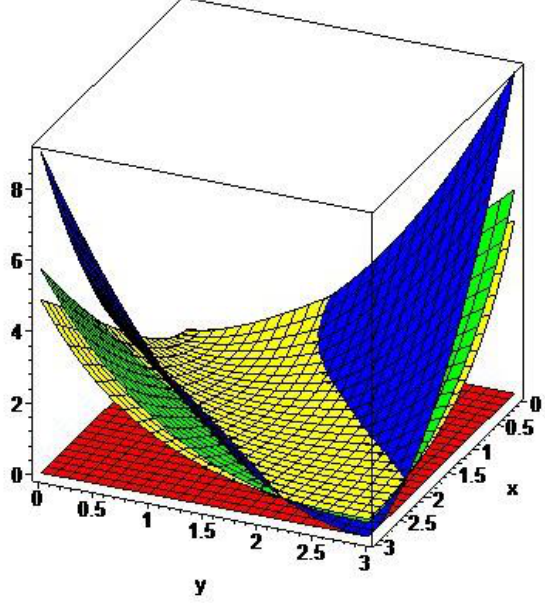
Figure 1. Approximation of R G n , n ( ϕ ) to ϕ (blue) on [ 0,3 ] × [ 0,3 ] for n = 5 (red), n = 25 (yellow), n = 75 (green).